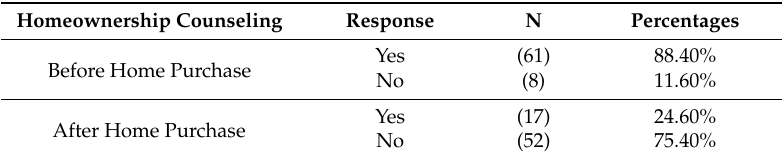
Table 17. Homeownership Counseling by Houston Habitat Homeowners